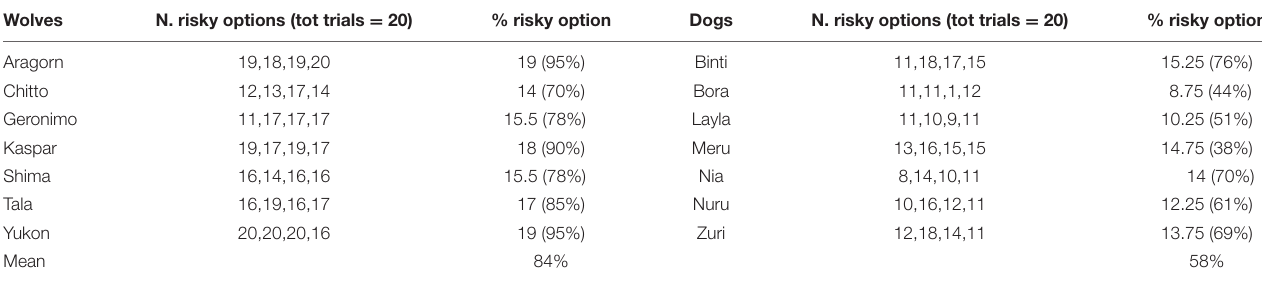
Mean ± SE for correct choices are indicated in each cell alongside the test statistics comparing performance to chance level. TABLE 5 | Number of risky choices in each session, as well as total number (and percent) of risky choices made over all test sessions by each individual for wolves and dogs. Wolves N. risky options (tot trials =